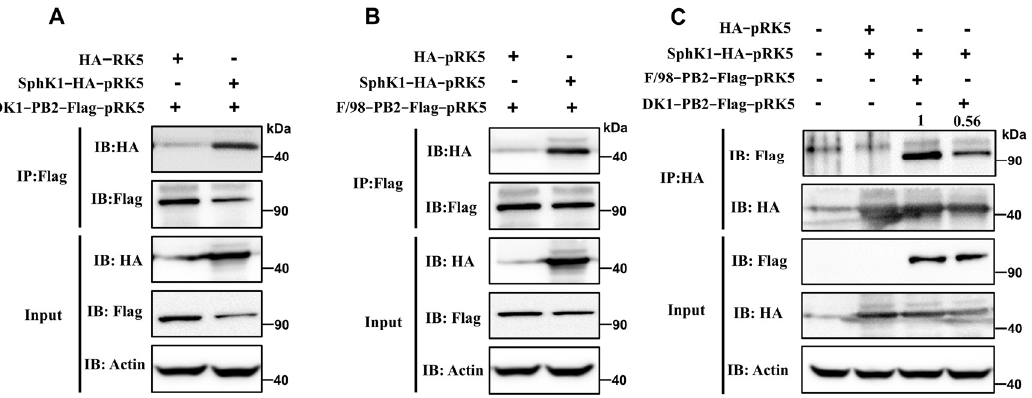
Figure 5. Interaction of SphK1 with PB2 proteins of different lineages. According to the plasmid transfection mode shown in the figure, 2 µ g of the corresponding plasmids were transfected in the corresponding 293T cell wells. The cells were collected 24 h after transfection, immunoprecipitated with Flag antibody, and Western blotting was performed with HA and Flag antibody to detect whether ( A ) the DK1-like PB2 protein and ( B ) the F/98-like PB2 protein can interact with the SphK1 protein; ( C ) According to the plasmid transfection mode shown in the figure, 2 μ g of the corresponding plasmids were transfected in the corresponding 293T cell wells. The cells were collected 24 h after transfection, and HA antibody was used for immunoprecipitation, and HA and Flag antibodies were used for Western blotting test to detect the interaction strength of SphK1 protein with F/98-like PB2 protein and DK1-like PB2 protein (IP: immunoprecipitation, IB: immunoblotting, Input: refer to whole cell lysates, Actin was used as a loading control).